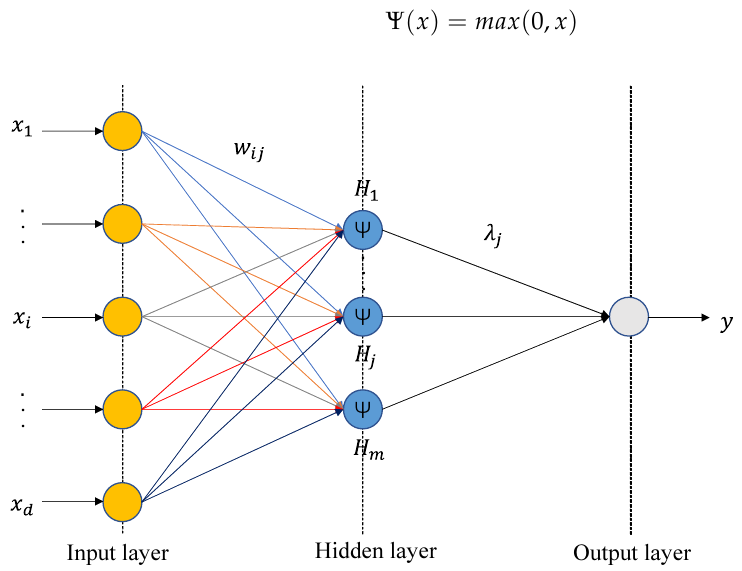
Figure 3. A multilayer perceptron (MLP) network with one hidden